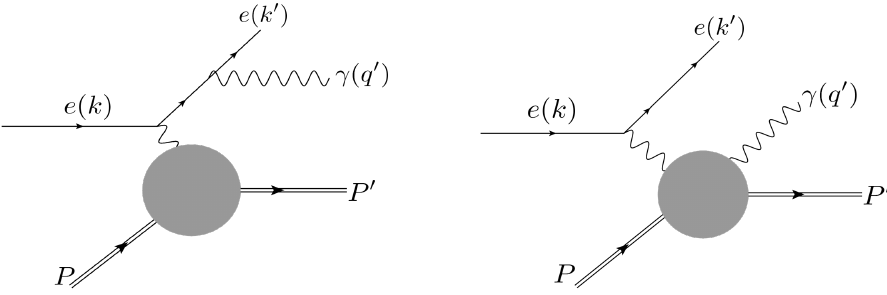
Figure 1 . The Bethe-Heitler (left) and the DVCS (right) processes that contribute to the real photon